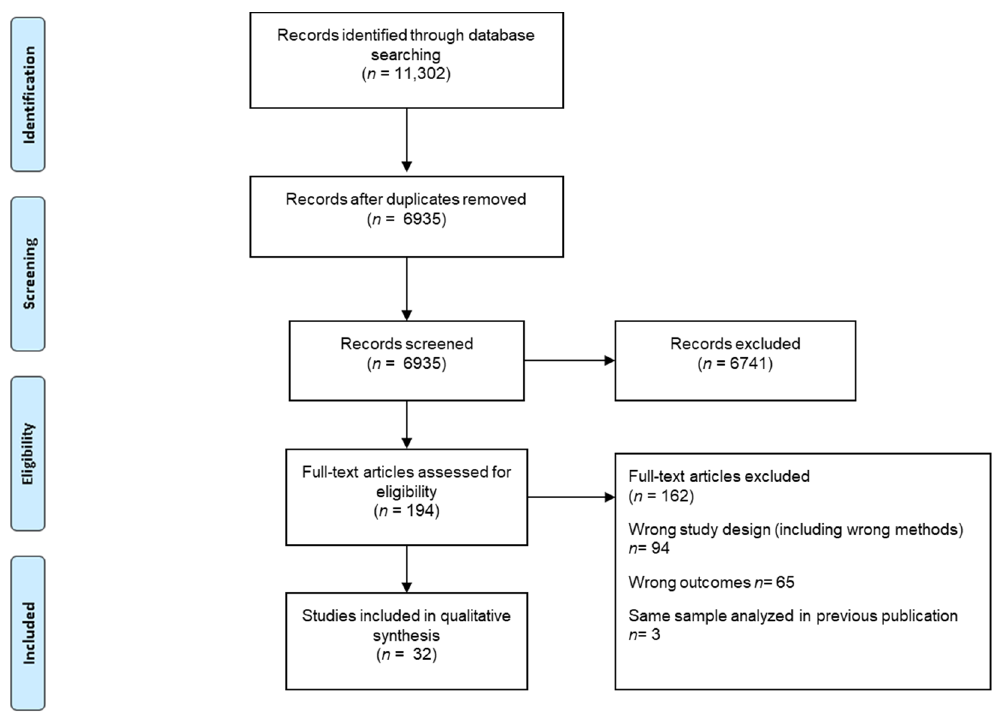
Figure 1. Flowchart of the identification of included studies.